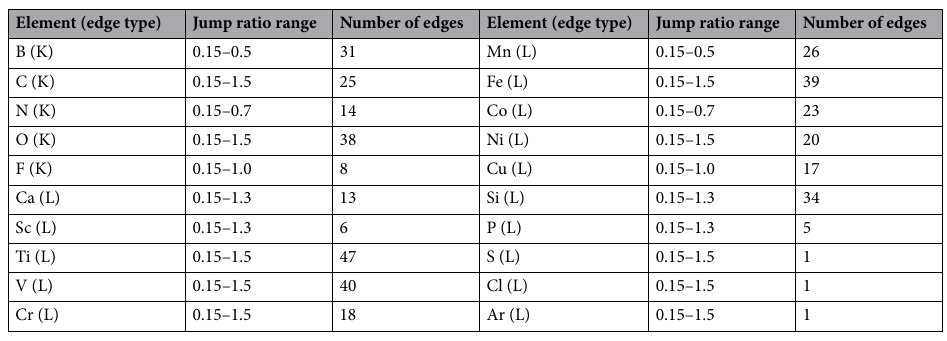
Table 1. Edge library 14–65 .